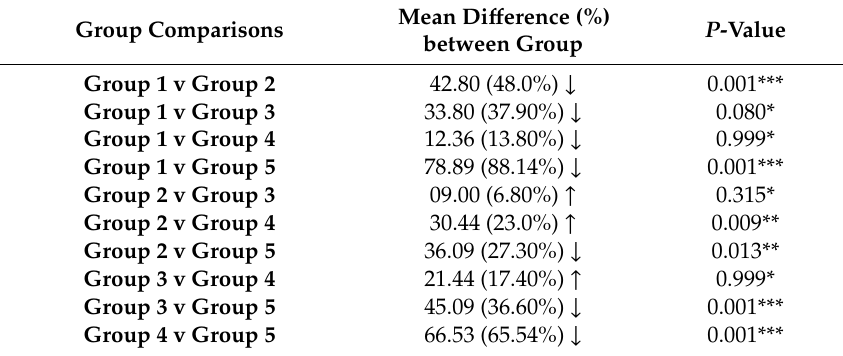
Table 3. Inter-group statistical comparison of mean flexural strength.